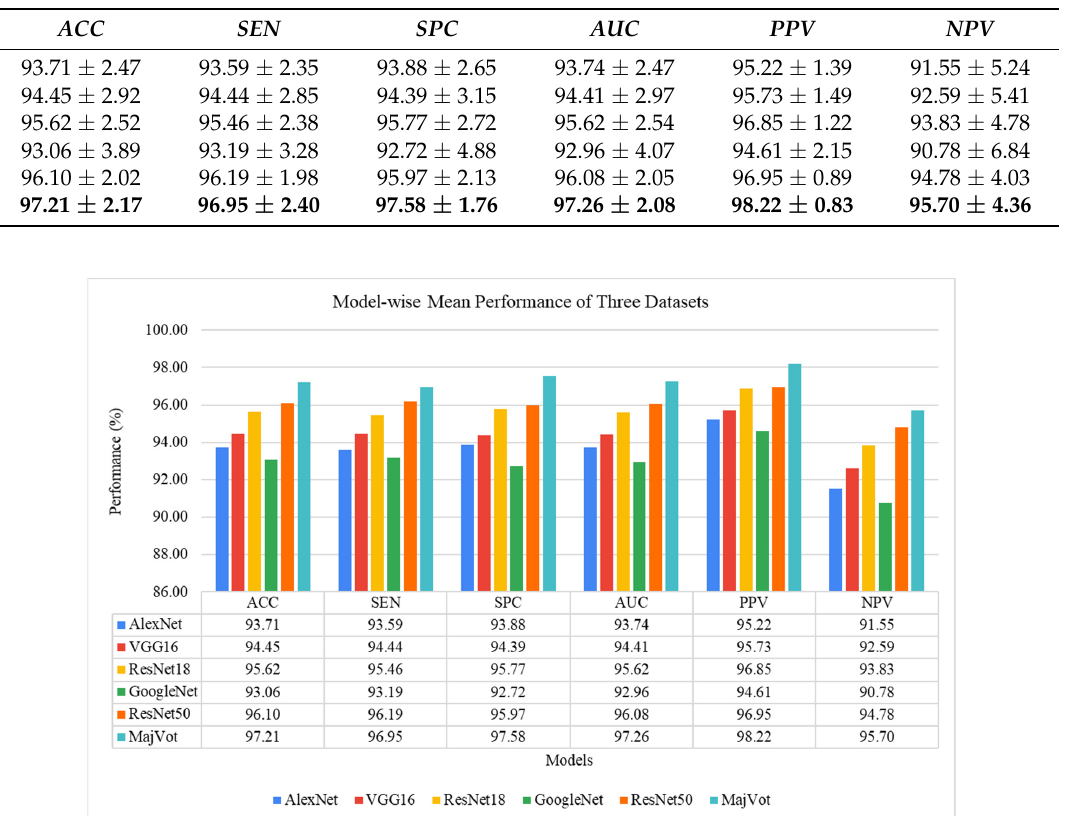
Table 13. The model-wise average performance of three datasets.